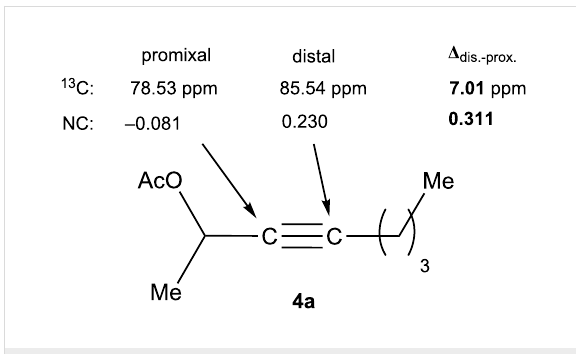
Figure 2: Natural charges at and the 13 C chemical shifts of the alkynyl carbons in 4a .